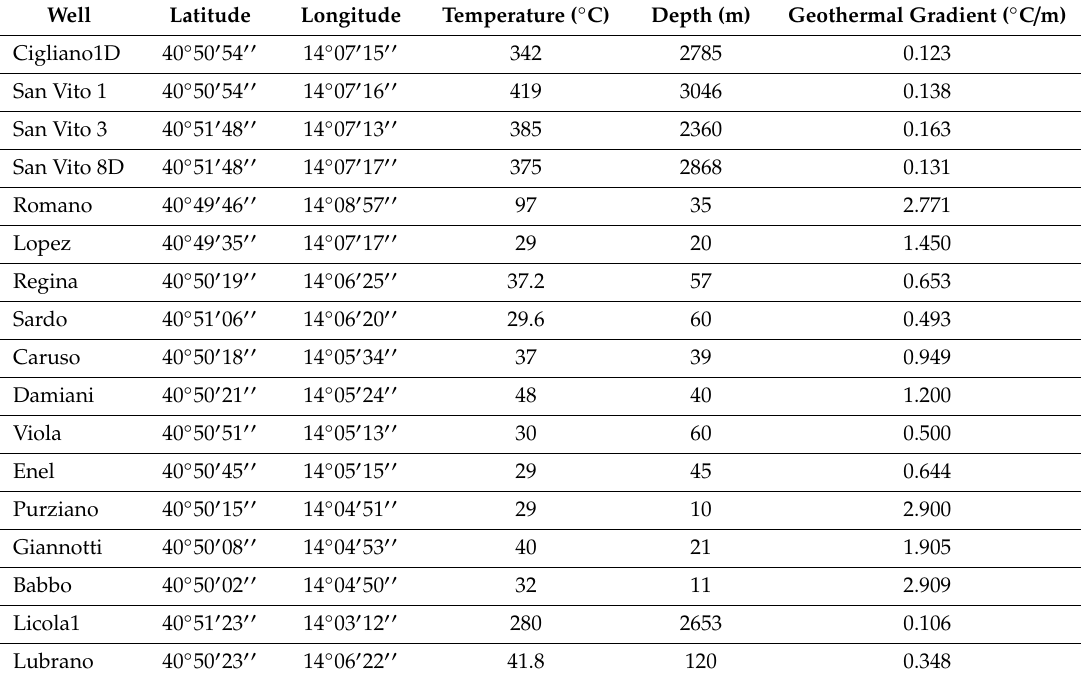
Table 1. Collection data of wells in Phlegraean